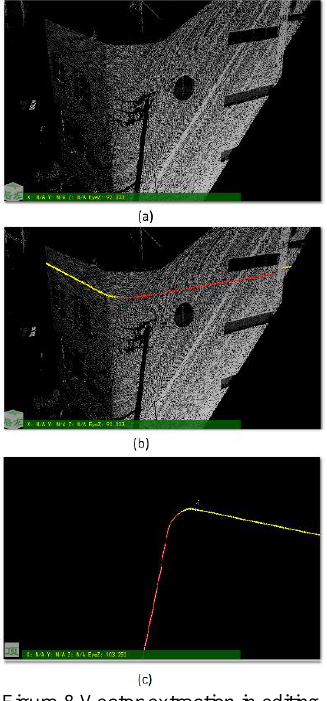
Figure 8.Vector extraction in